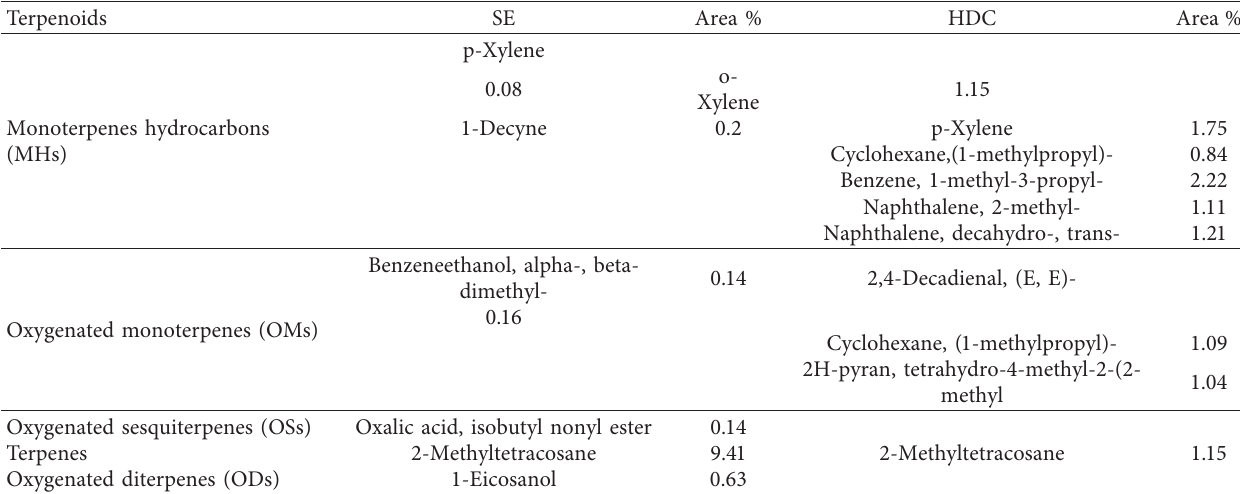
Table 3: Different types of terpenoids present in each of the method used for the extraction.